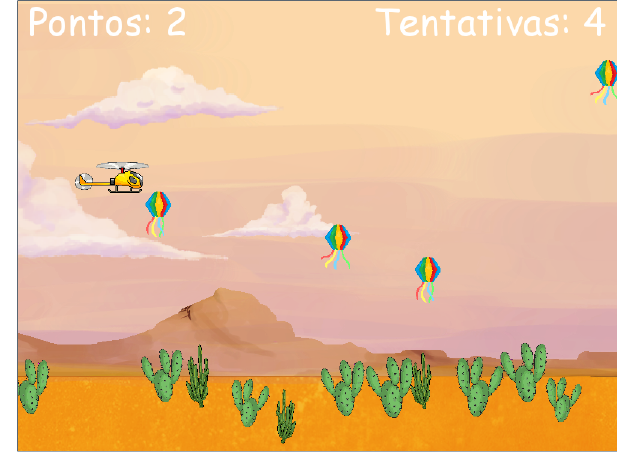
Fig. 1: Game environment showing a typical scene found in the interior region of northeastern